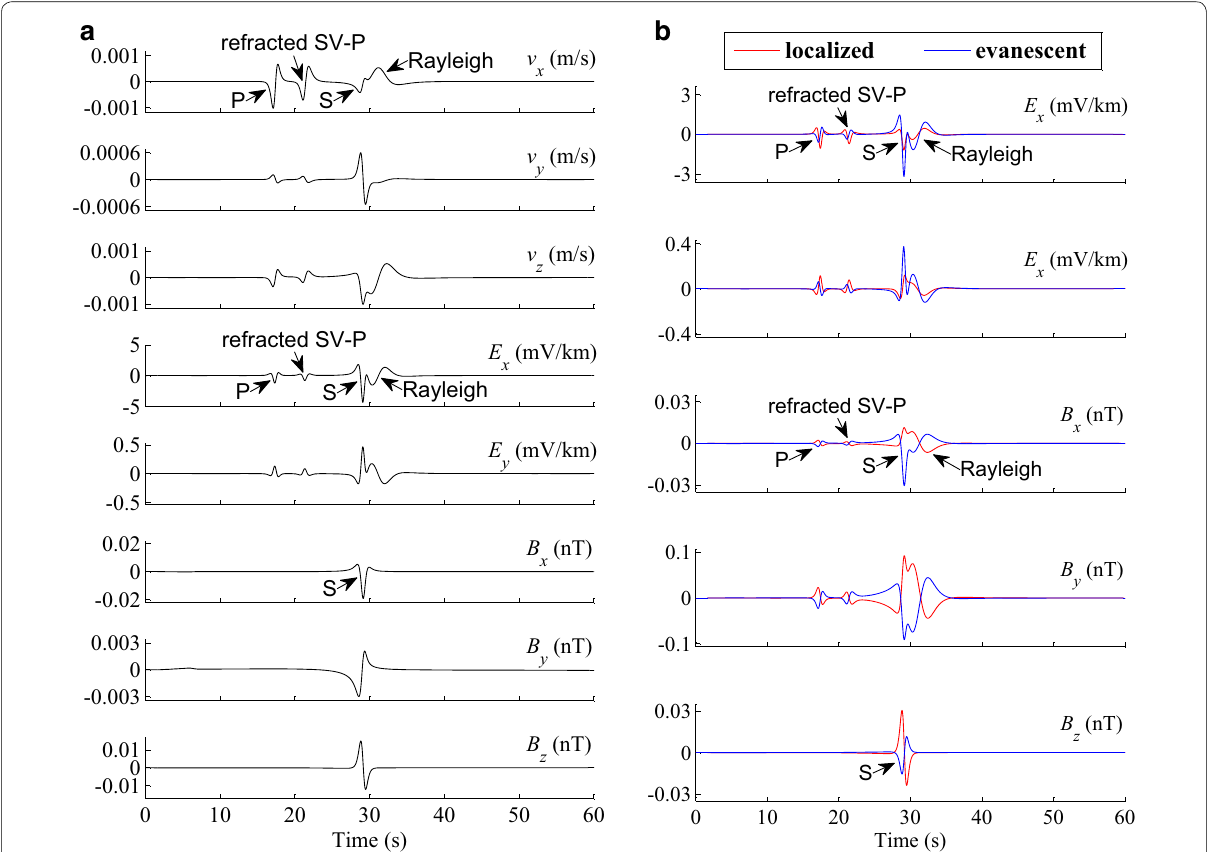
Fig. 4 Seismic and EM signals simulated for the water‑saturated half‑space porous model. Multiple components of a seismic and EM wave‑fields and b localized and evanescent EM waves are calculated for a receiver nearby the ground surface, which is located at (